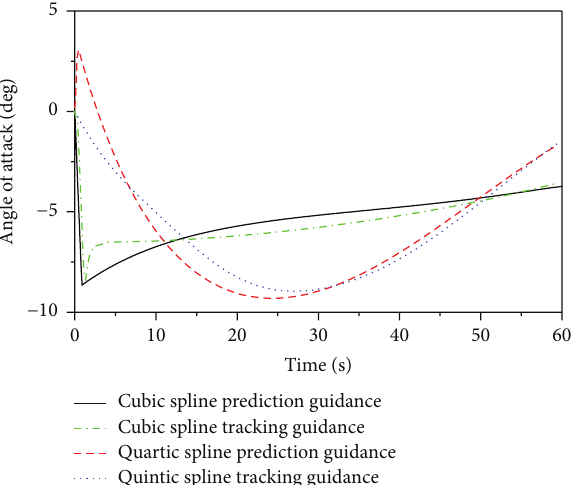
Figure 4: Different spline guidance methods.